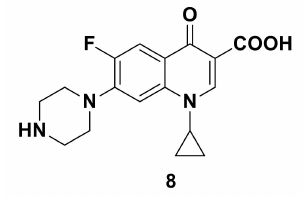
Figure 5. Structure of